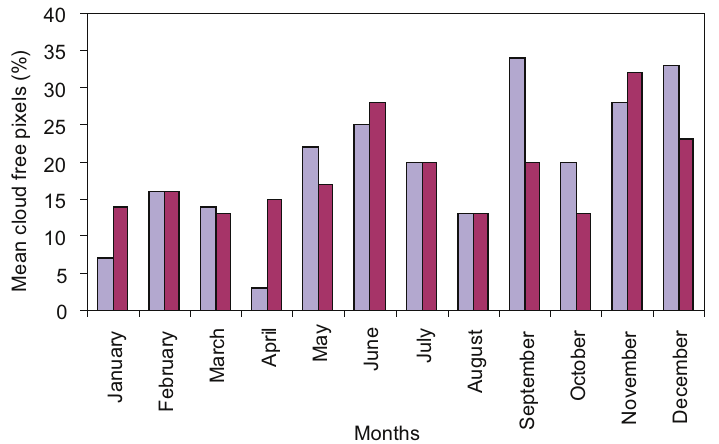
Fig. 7. Monthly variations of mean cloud-free pixels in the study